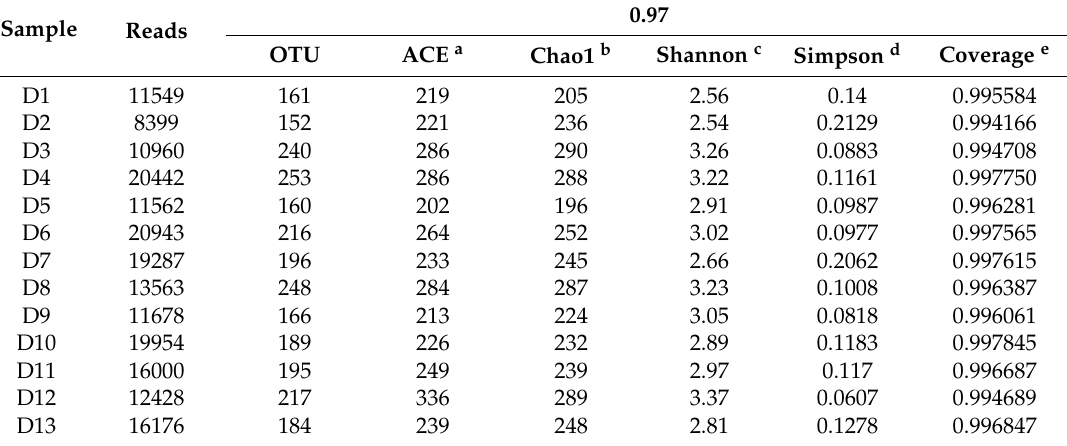
Table 2. Richness and diversity estimators of the bacterial communities of bulk sludge and cake sludge in the M-AnMBR and A-AnMBR.